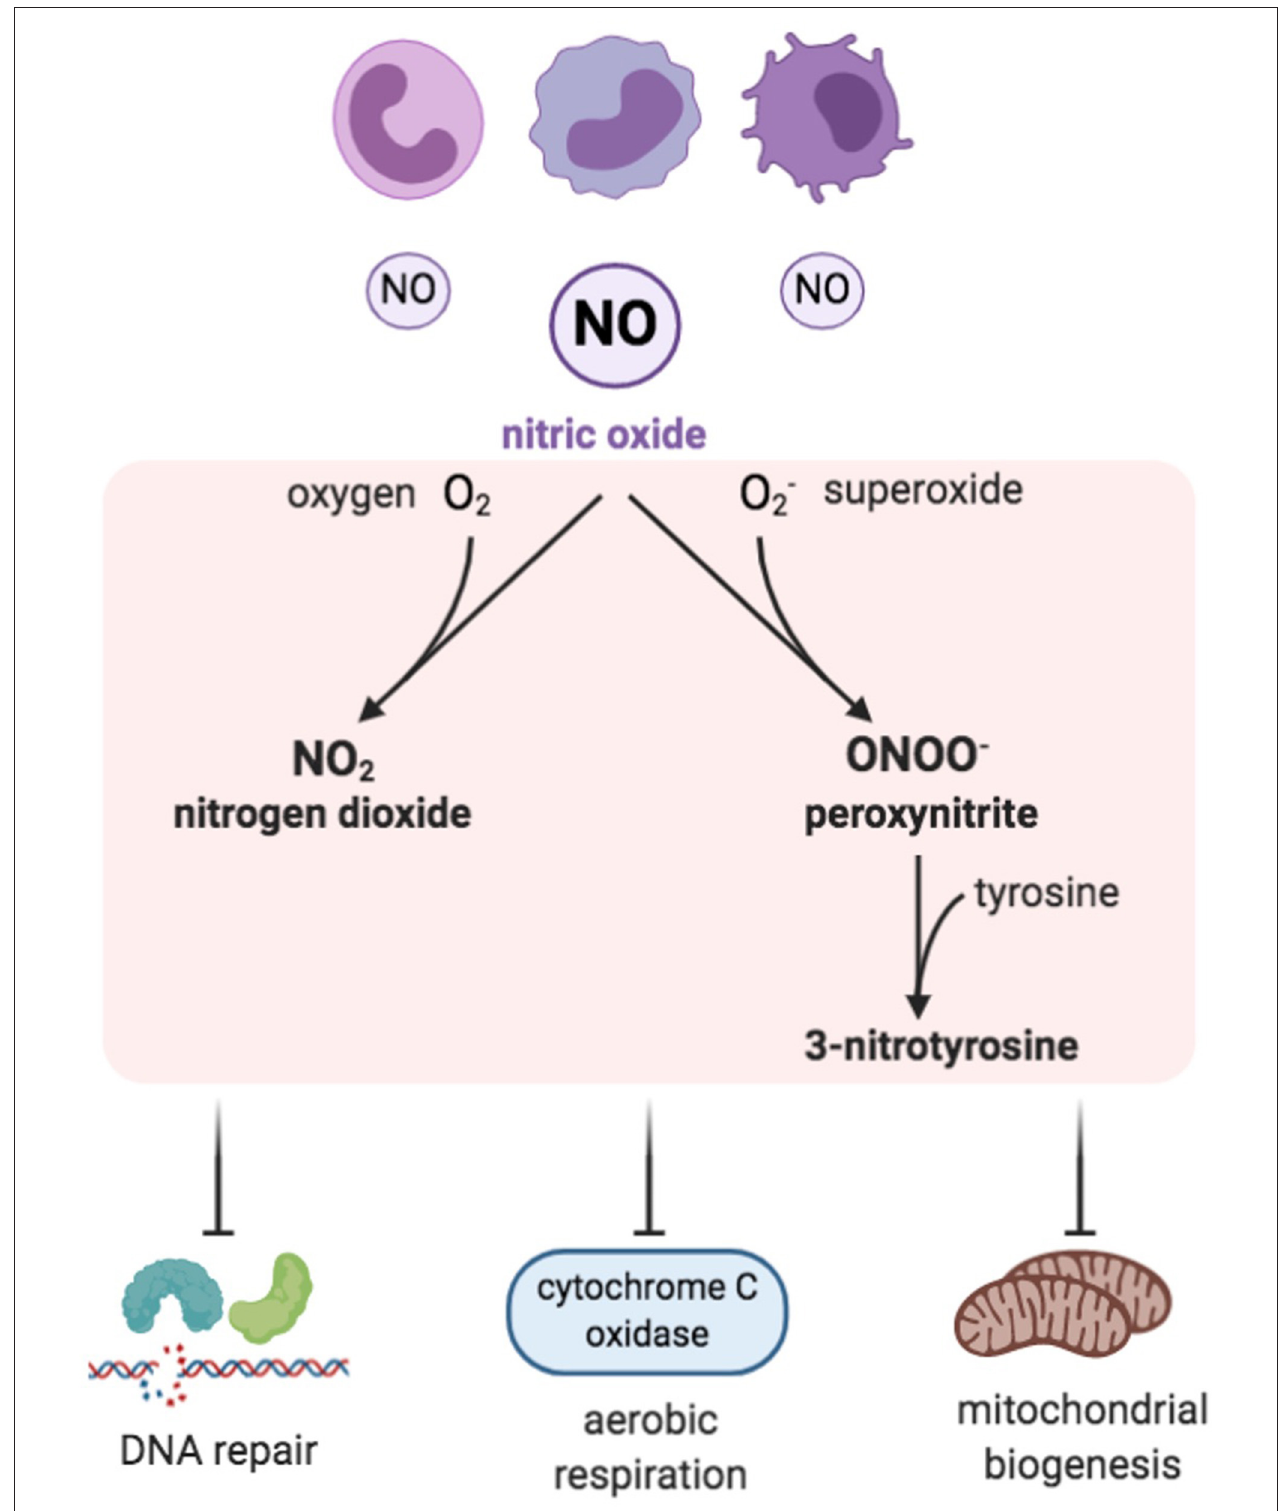
FIGURE 3 | Reactive nitrogen species (RNS). Inflammatory cells are a prominent source of nitric oxide and, when in excess, RNS are formed by combining NO with ROS, especially with superoxide. Examples of RNS include peroxynitrite, nitrogen dioxide, and 3-nitrotyrosine, which have inhibitory effects on DNA repair enzymes, cytochrome c oxidase, and mitochondrial